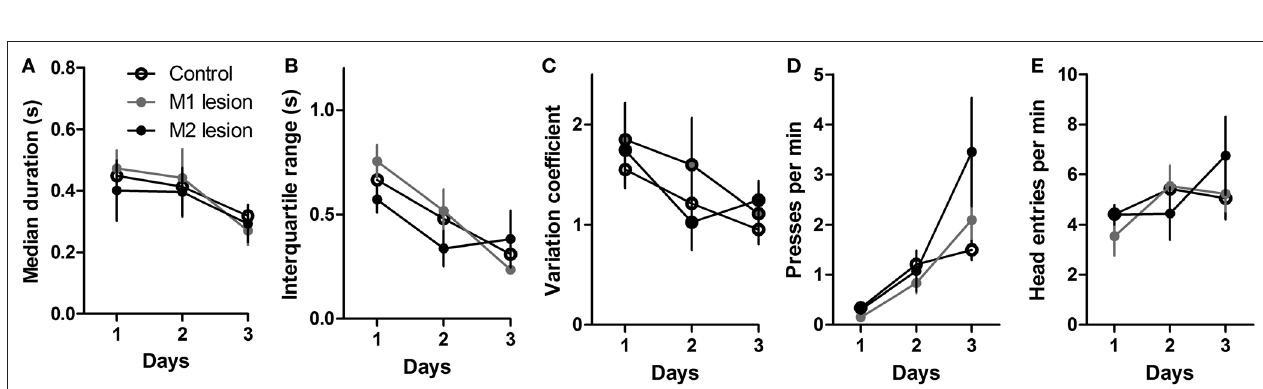
range (IQR) of the press durations during the same period. (C) Variation coefficient (IQR/median). (D) Rate of lever pressing during 3 days of CRF training. (e) Rate of head entries into the food